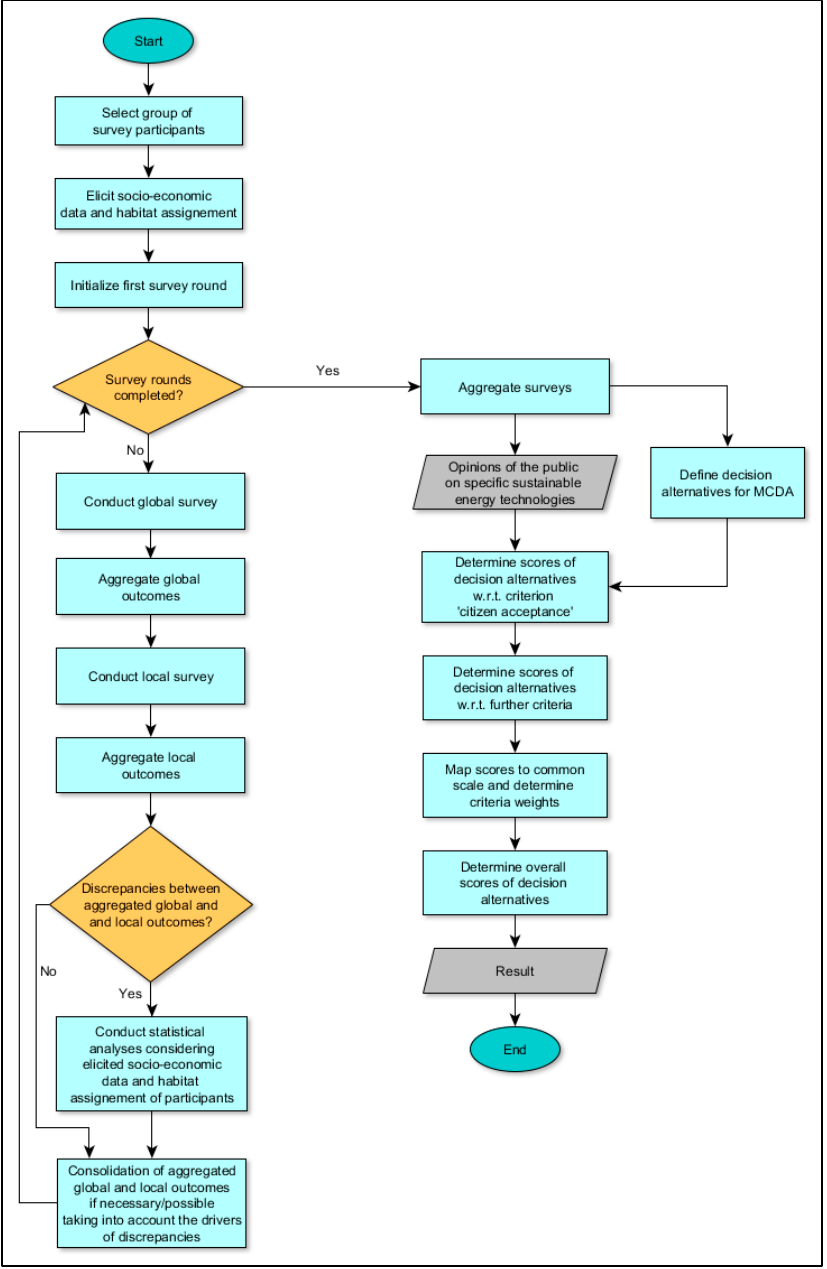
Figure 1. Flowchart illustrating the steps of the decision support methodology.